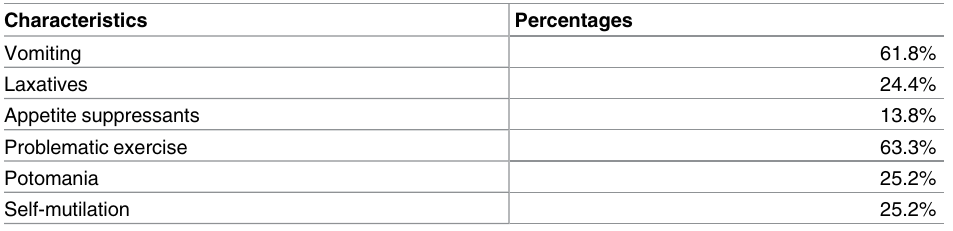
Table 1. Characteristics (current or past) associated with ED (N =